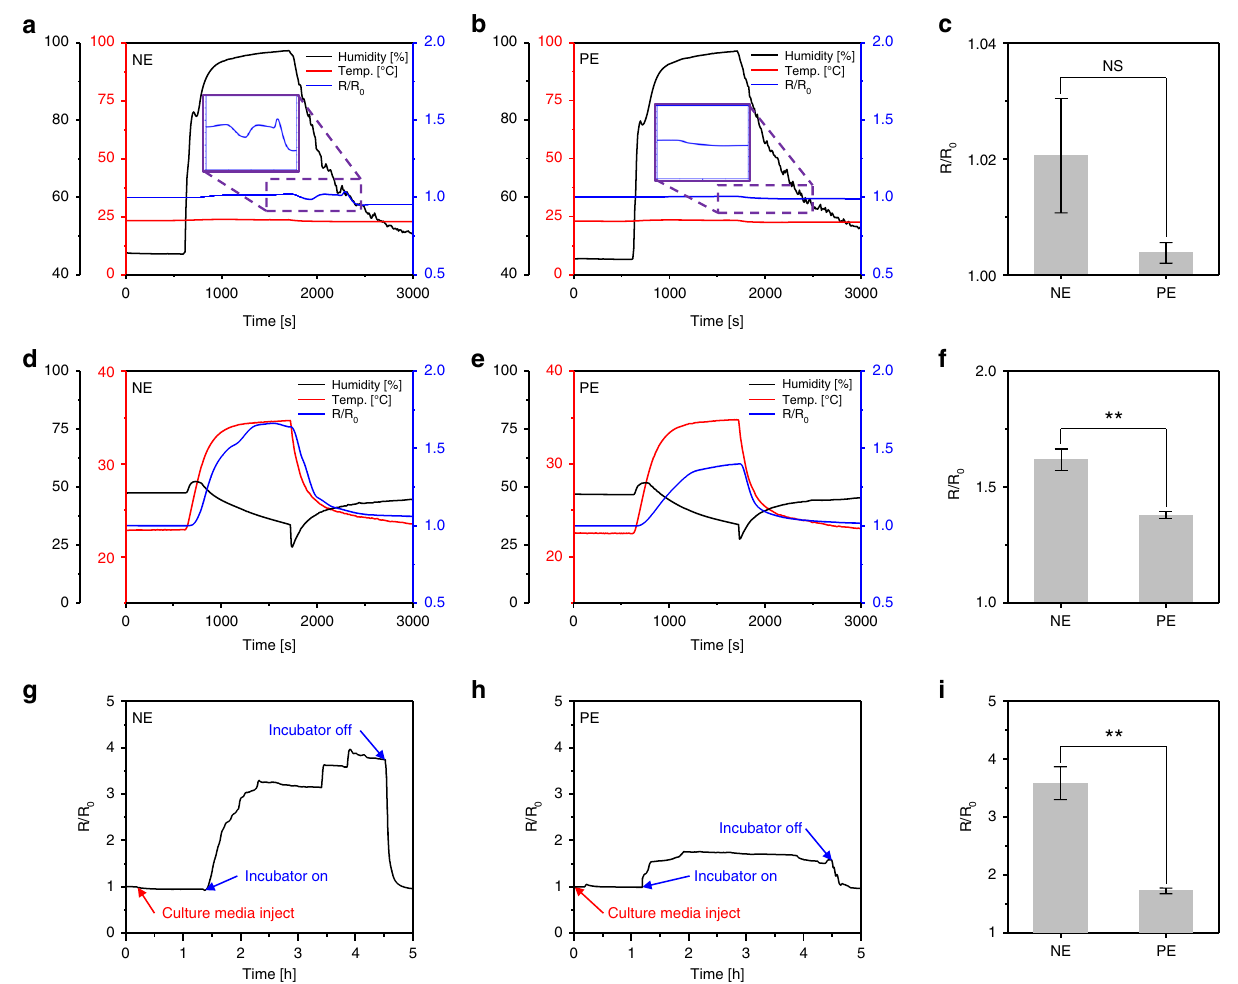
Fig. 2 Change in resistance of the crack sensors with and without PDMS encapsulation. a – c Performances of the crack sensors as a function of humidity changes (45 – 95%). d – f Effect of temperature. g – i Stability of the PDMS-encapsulated crack sensor in a stage top incubator at 37 °C. (NE and PE represent nonencapsulation and PDMS encapsulation). c , f , i Error bars are mean ± s.d. ( n = 5, * p < 0.05, ** p <